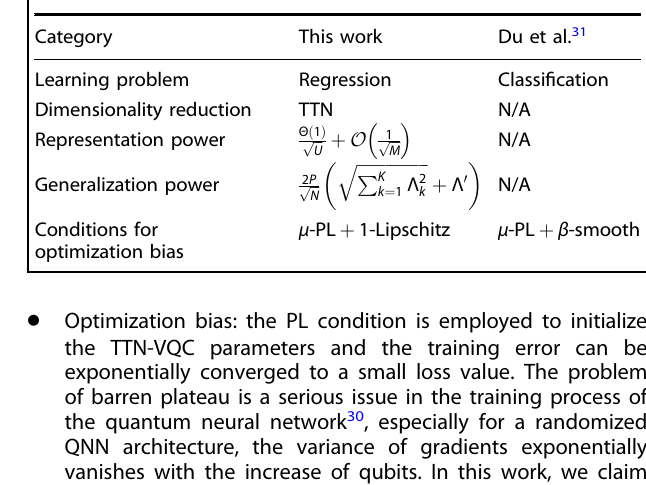
Table 1. A comparison of learning theory for VQC between this work and Du et al. 31